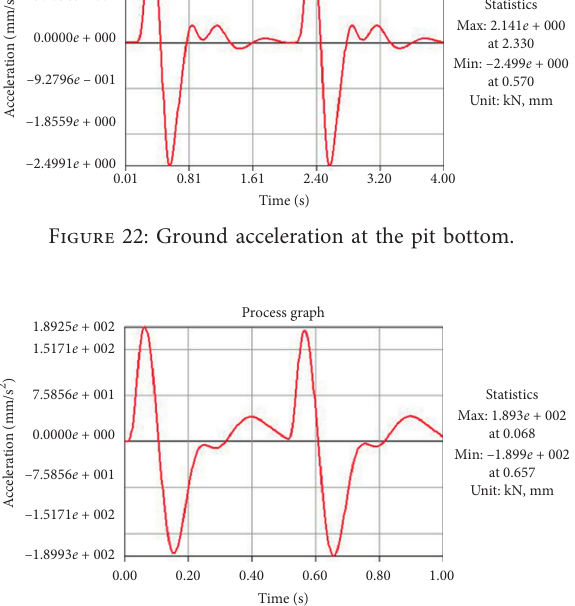
Figure 23: Acceleration at the top of the foundation pit cover near the wharf.